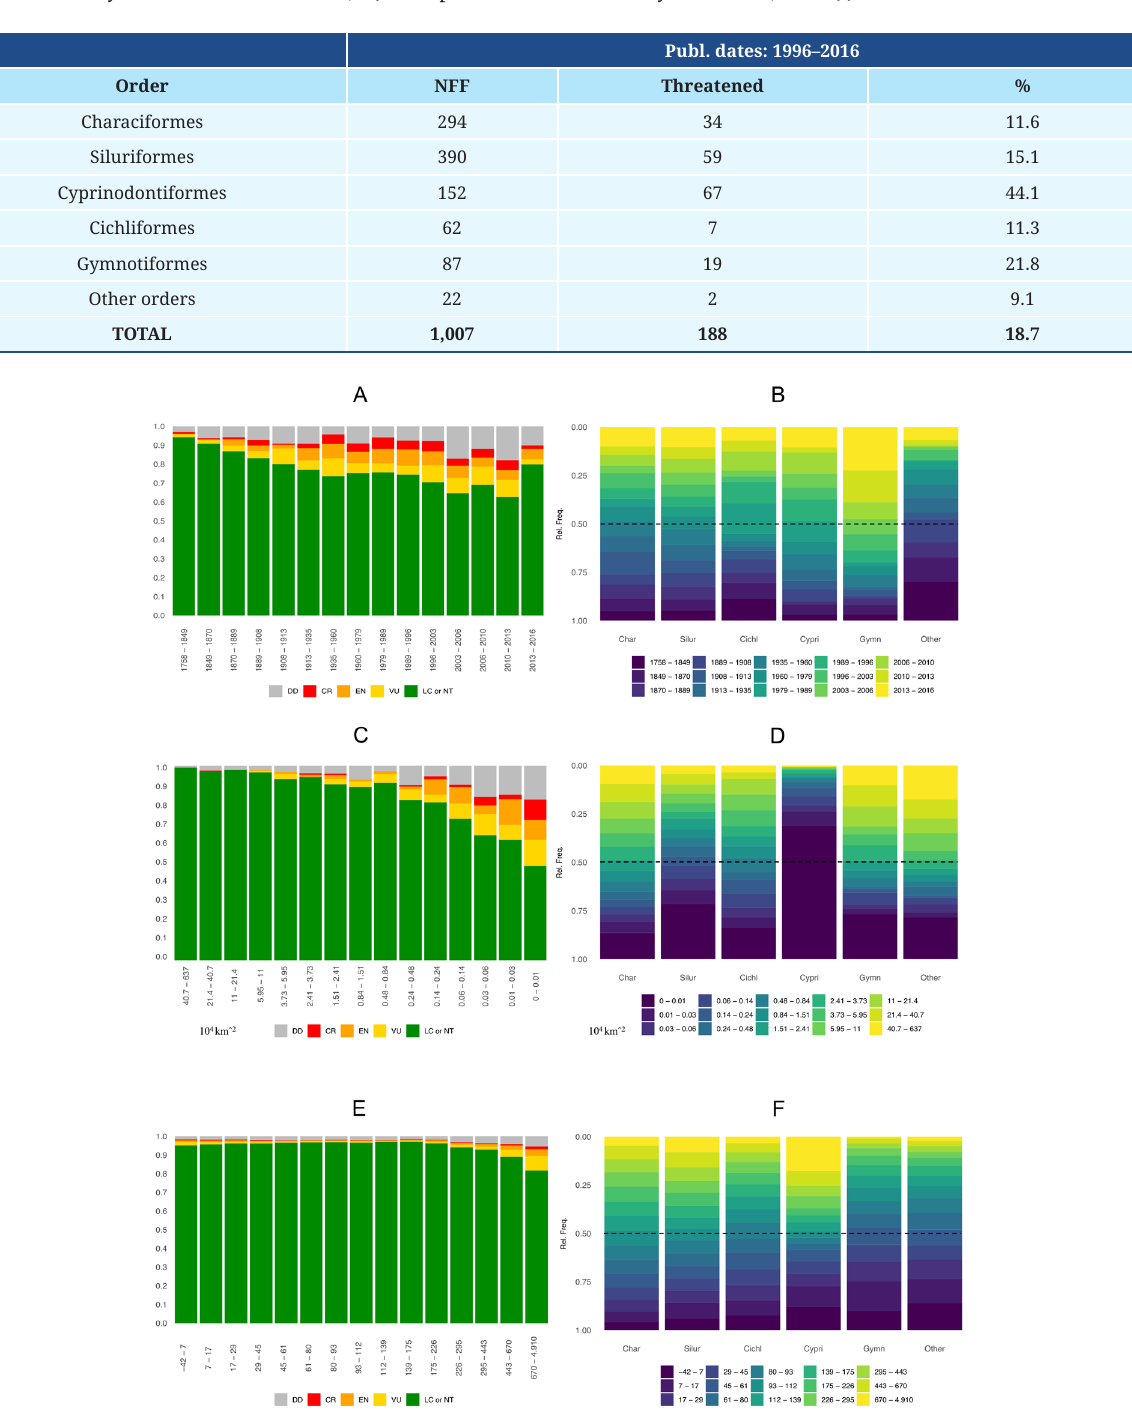
TABLE 2 | Summary of the IUCN–RL data for 1,007 NFF species described in a 20–year interval, from 1996 to